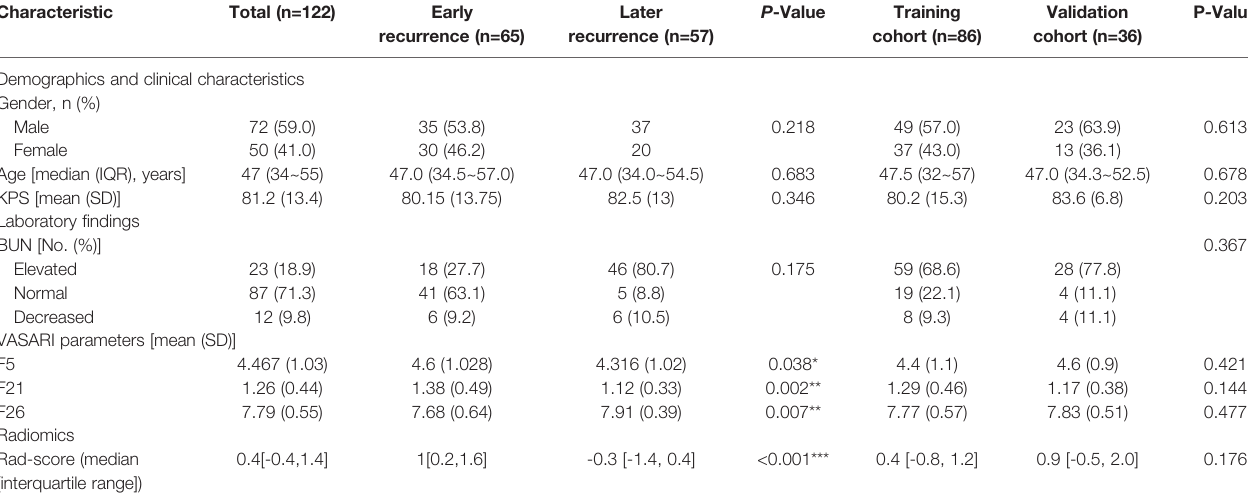
TABLE 1 | Demographic, clinical, laboratory, VASARI parameters and radiomic score (Rad-score) of the 122 patients with glioblastoma (GBM). Characteristic